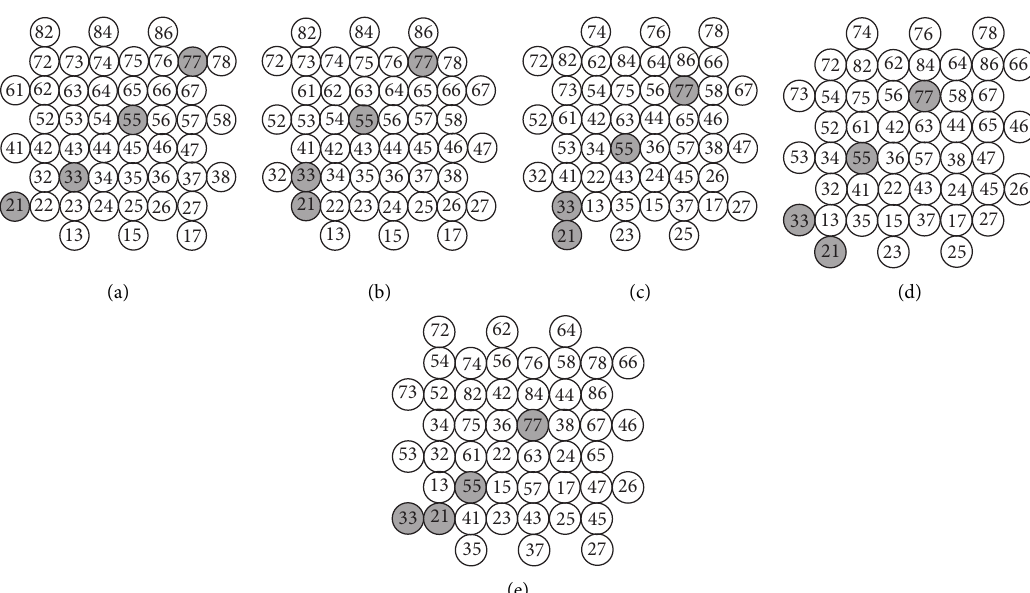
Figure 2: Diagram of the 3D braided composite prefabricated part braiding process. (a) Original state. (b) First steps. (c) Second steps. (d) Third steps. (e) Fourth